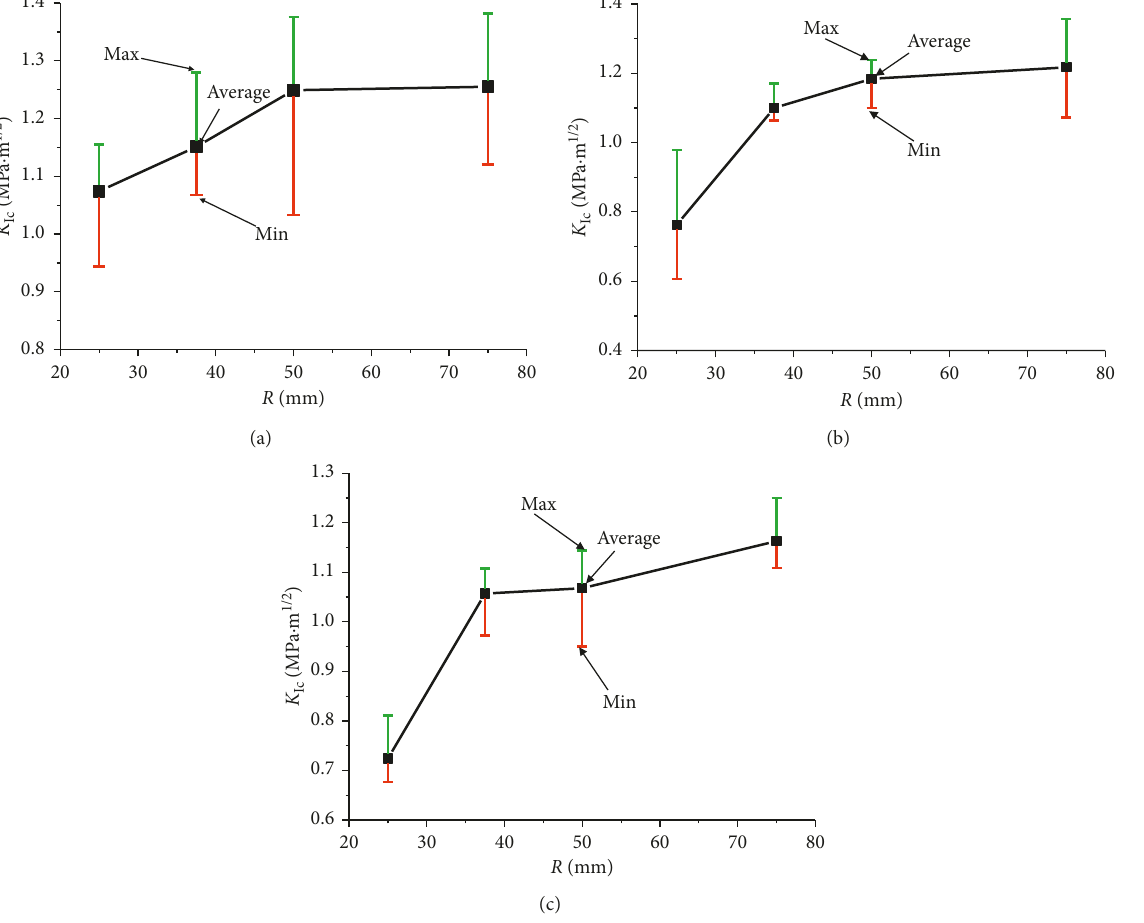
Figure 4: Fracture toughness test value dependence on the sample radius. (a) α � 0.4. (b) α � 0.5. (c) α �